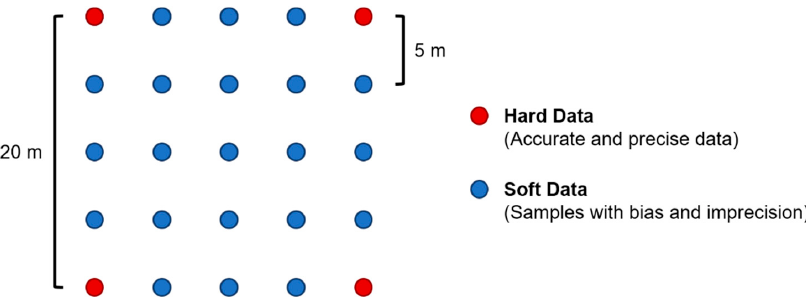
Figure 2. Schematic representation of the modifications performed to the original exhaustive dataset. Two types of data were considered: samples without and with measurement errors.